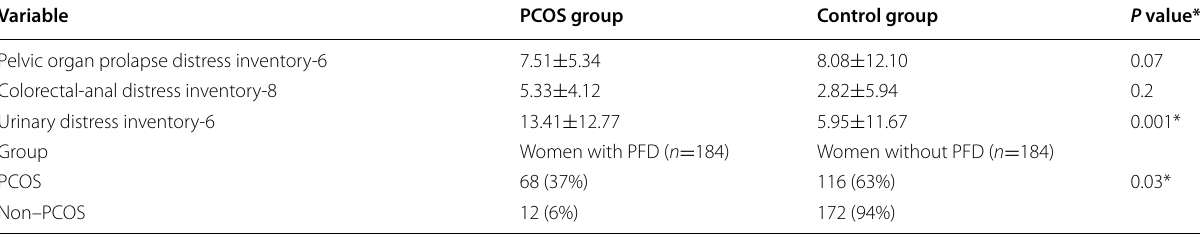
SD standard deviation, PFD pelvic floor dysfunction, *significant difference at P < 0.05